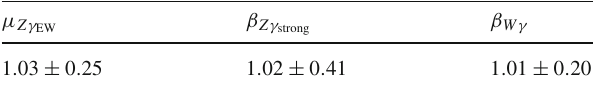
Table6 Thebest-fitvaluesandcorrespondinguncertaintiesofthethree free-floating normalization factors derived from the statistical analysis described by Eq. (3) μ Z γ